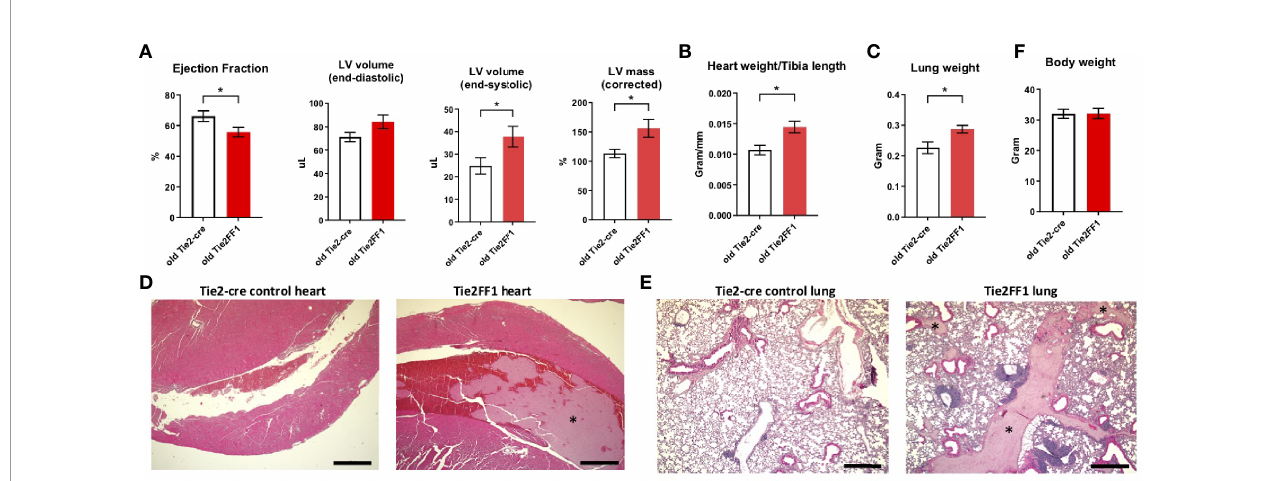
FIGURE 5 | Persistent cardiomyopathy and congestive heart failure in the old Tie2FF1 mice. (A) Measurements of left ventricular (LV) ejection fraction, end-diastolic and end-systolic volume, and mass by transthoracic echocardiography in 18mo old Tie2-cre control and Tie2FF1 mice. (B) Heart weight adjusted by tibia length of 18mo old Tie2-cre control and Tie2FF1 mice. (C) Lung weight of 18mo old Tie2-cre control and Tie2FF1 mice. (D) Representative H&E staining of transverse sections of heart from Tie2-cre control and Tie2FF1 mice. Note the presence of thrombus (*) in right ventricle (magni fi cation 4x, scale bar: 500uM). (E) Representative H&E staining of coronal sections of lung from Tie2-cre control and Tie2FF1 mice. Note the presence of thrombus (star*) in segment pulmonary arteries of the Tie2FF1 mice (magni fi cation 4x, scale bar: 500uM). (F) Body weight of 18mo old Tie2-cre control and Tie2FF1 mice. n=8-11 mice in each group.* P <